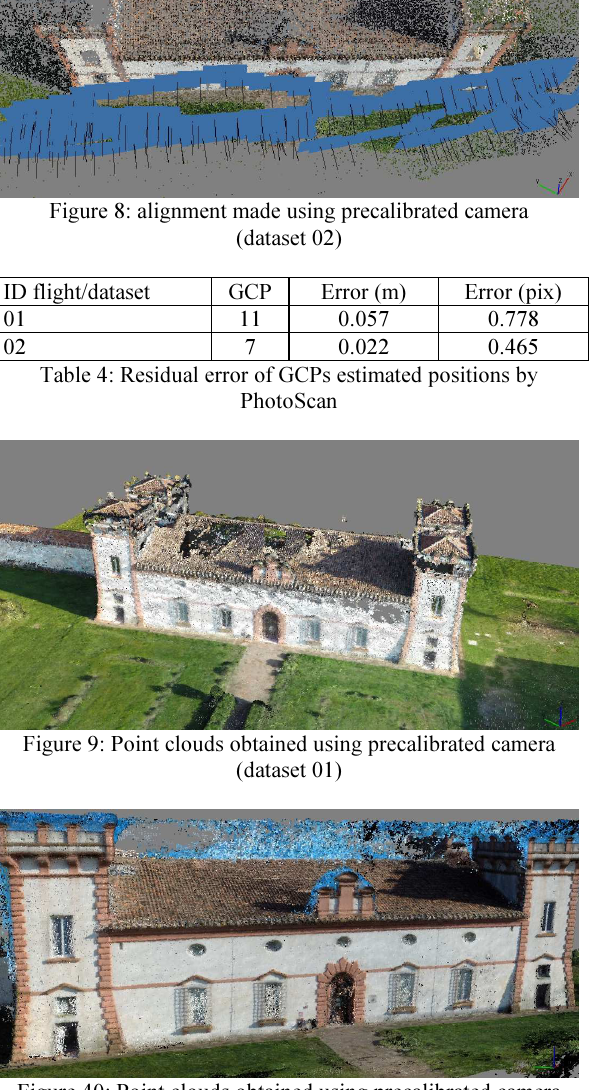
Figure 40: Point clouds obtained using precalibrated camera (dataset